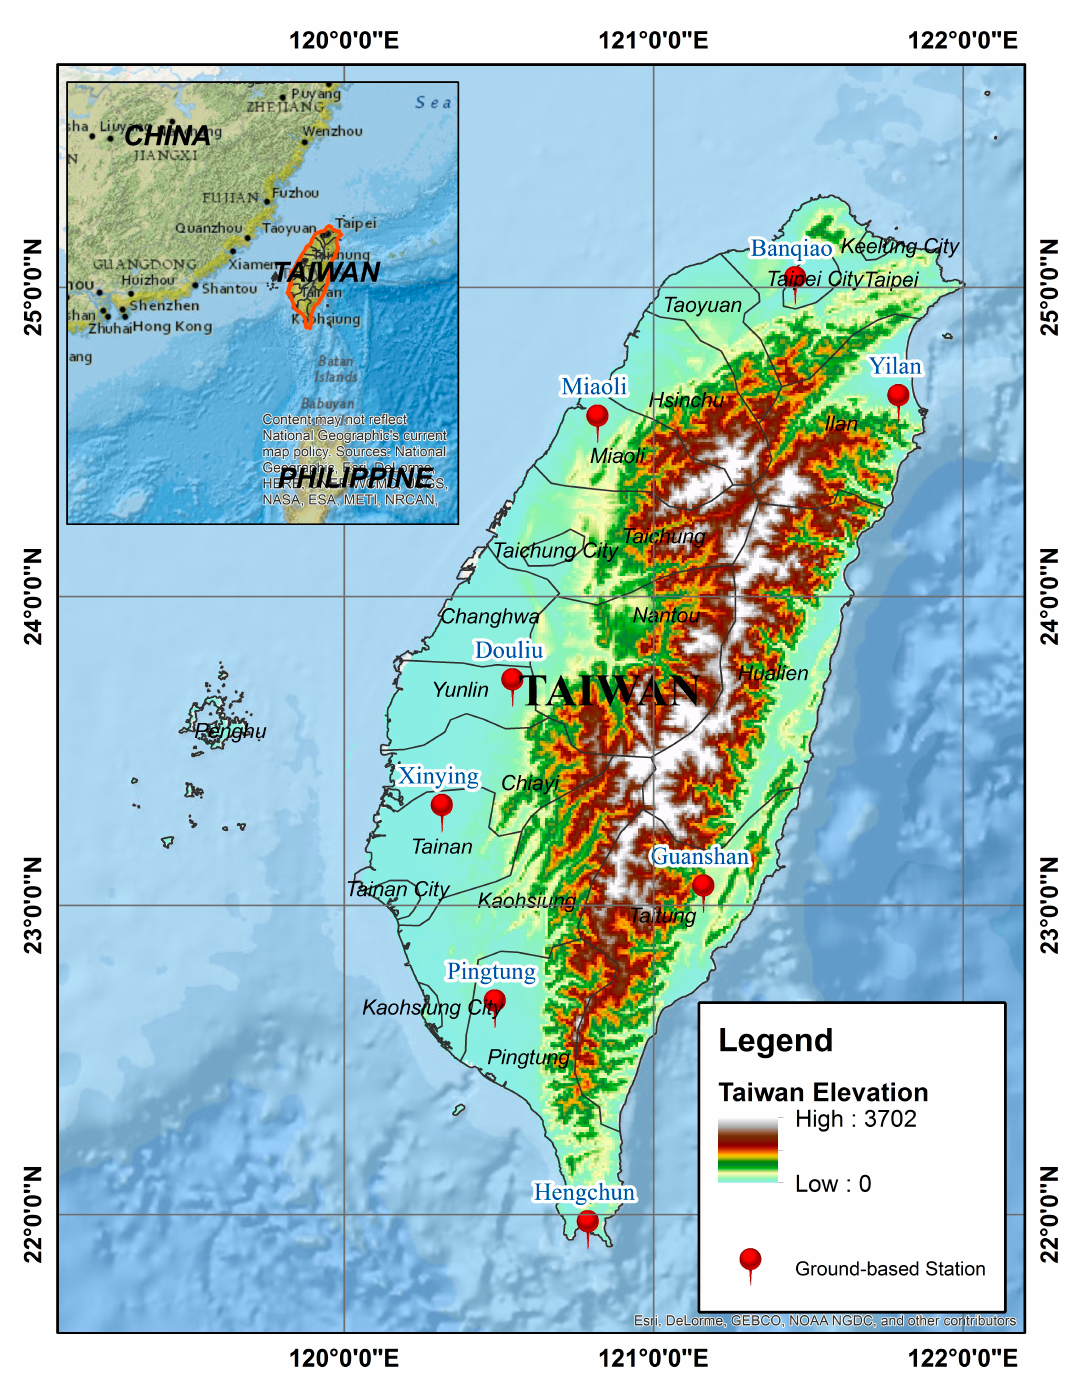
Figure 1. Map of Taiwan with the altitude overlaid in color scale. Grey lines denote the boundary of each individual city. The distribution of ground-based PM 2.5 measurement stations was acquired from the Taiwan Air Quality Monitoring Network (TAQMN). The eight pin-point locations on the map, Banqiao, Maoli, Douliu, Xinying, Yilan, Guanshan, Hengchun, and Pingtung, indicate the PM 2.5 measurement stations included in this study. The elevation data were obtained from Advanced Spaceborne Thermal Emission and Reflection Radiometer/Global Digital Elevation Model (ASTER GDEM) Version 2 at https://asterweb.jpl.nasa.gov/gdem.asp.